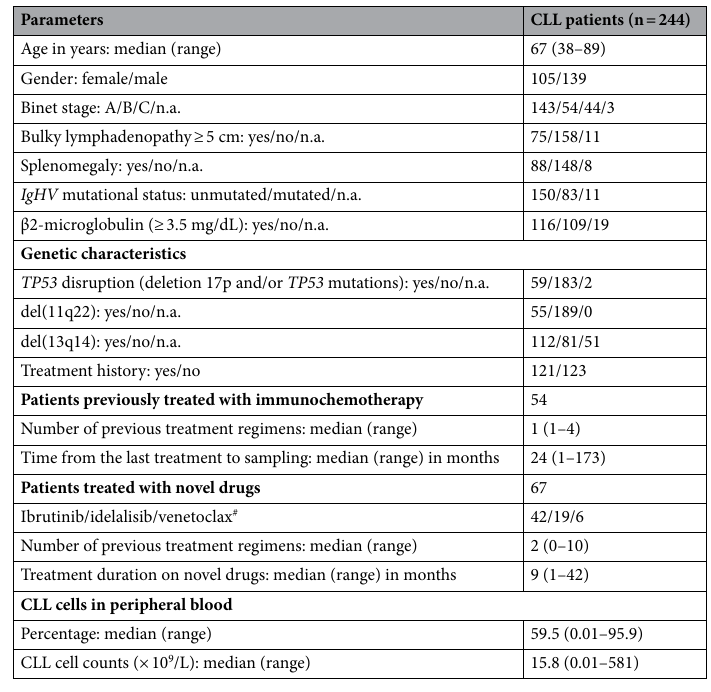
Table 1. Characteristics of CLL patients at sampling. n.a., not available; # 5 patients treated with venetoclax were ibrutinib-resistant; Next-generation sequencing was used to detect TP53 mutations, Sanger sequencing for IgHV mutational status and cytogenetics and FISH analysis for deletion 17p and other abberations, as previously reported 16–18